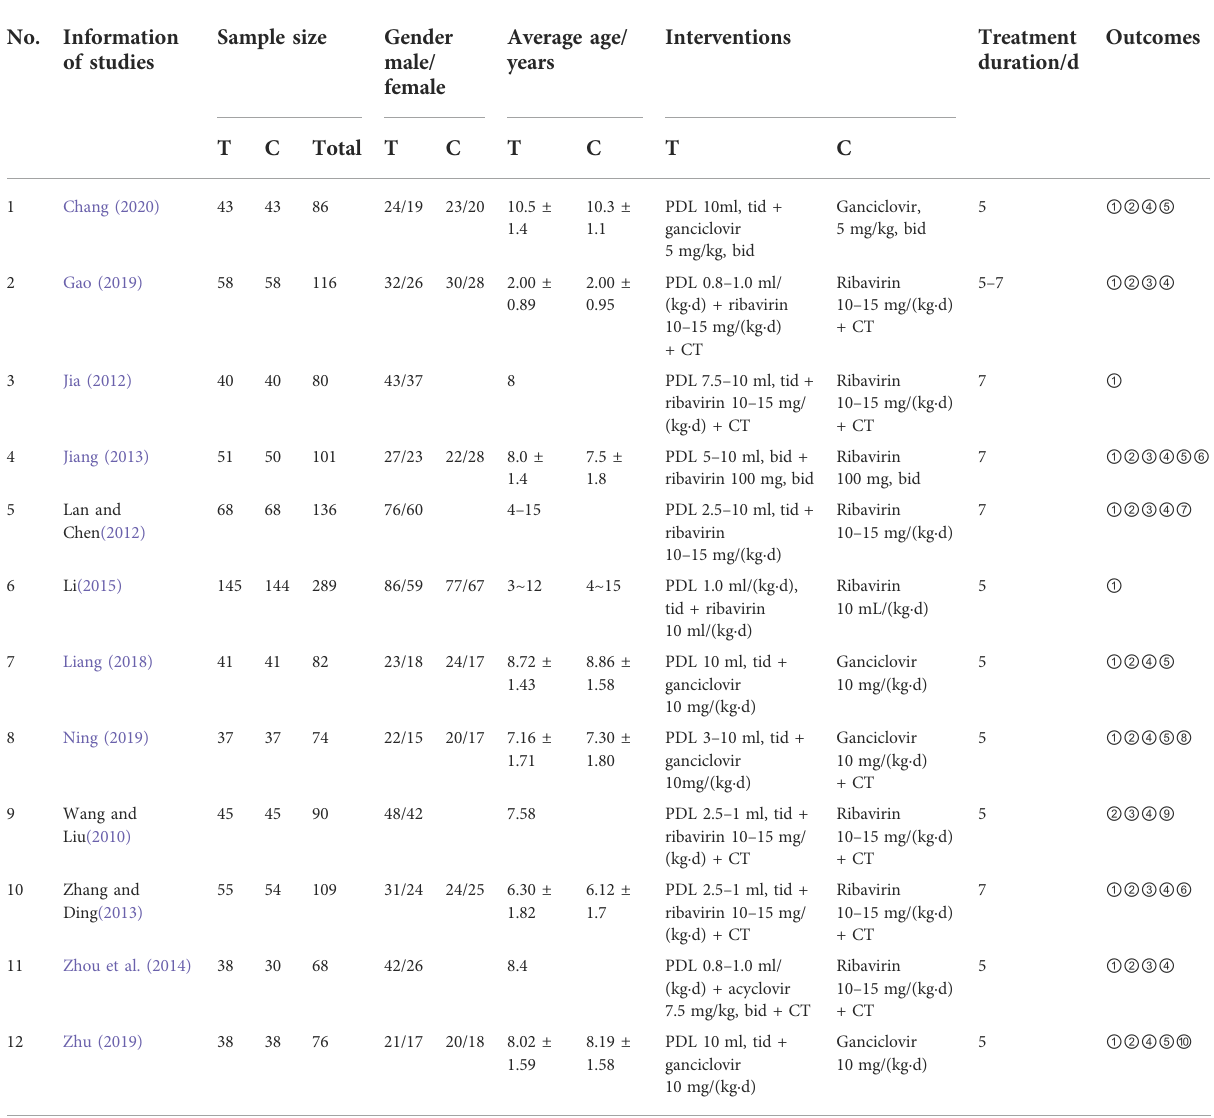
TABLE 1 Characteristics of the included